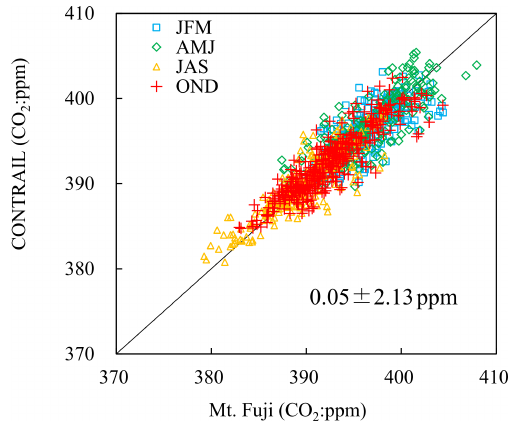
Figure 8. Scatterplots of CO 2 concentration at Mt. Fuji and ob- tained by CONTRAIL.